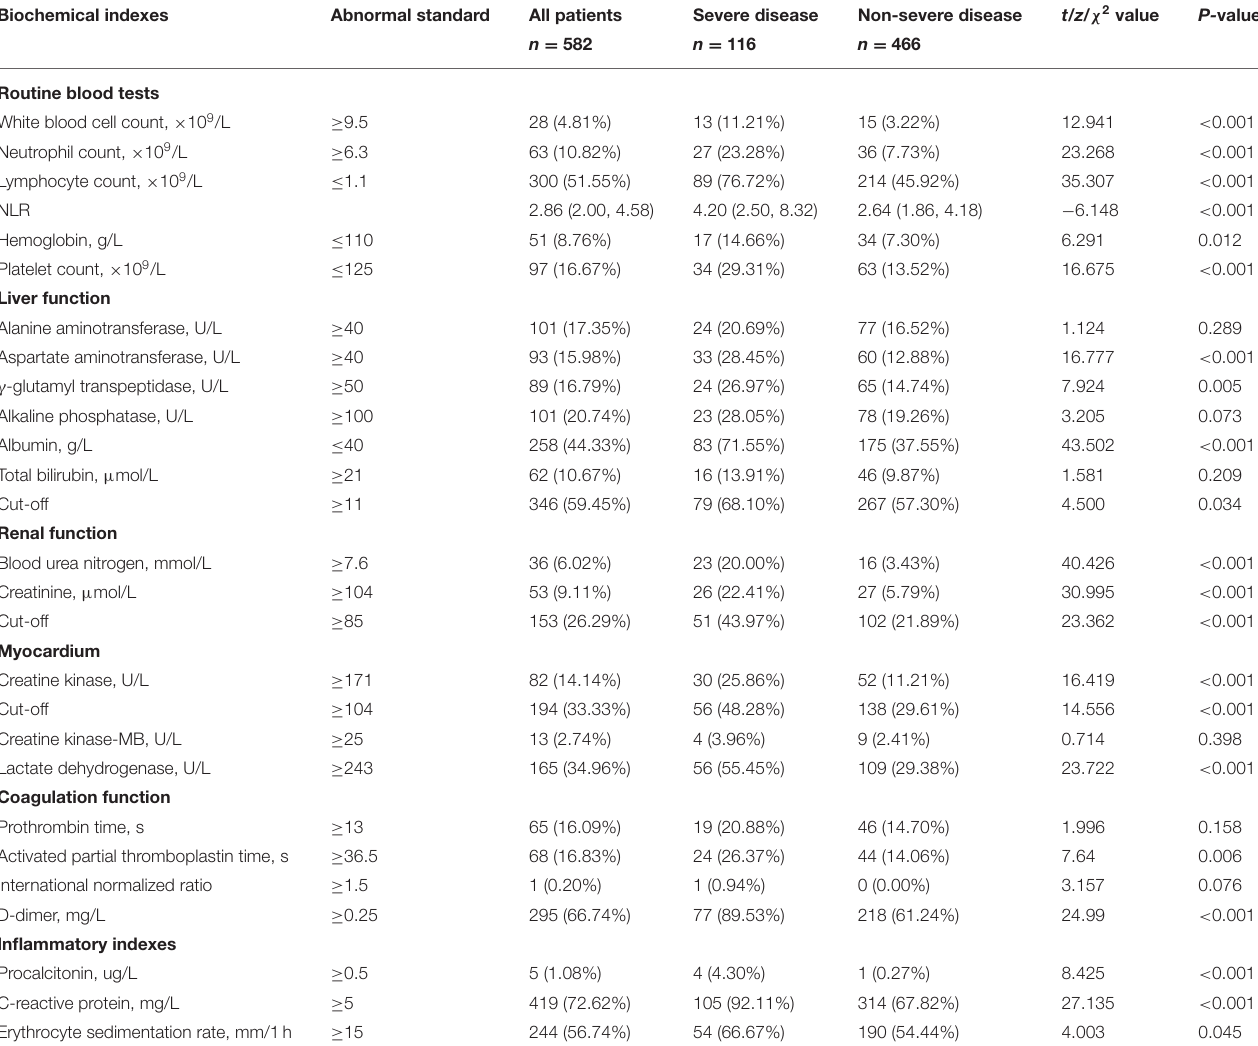
TABLE 2 | Baseline blood and biochemical indices of the COVID-19 patients at baseline. Biochemical indexes Abnormal standard All patients Severe